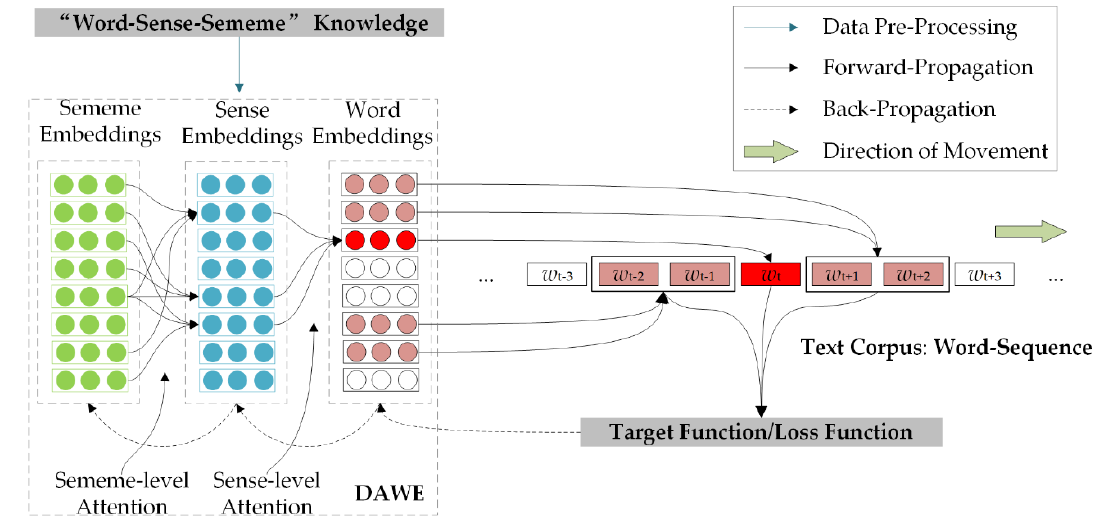
Figure 8. Training with DAT.